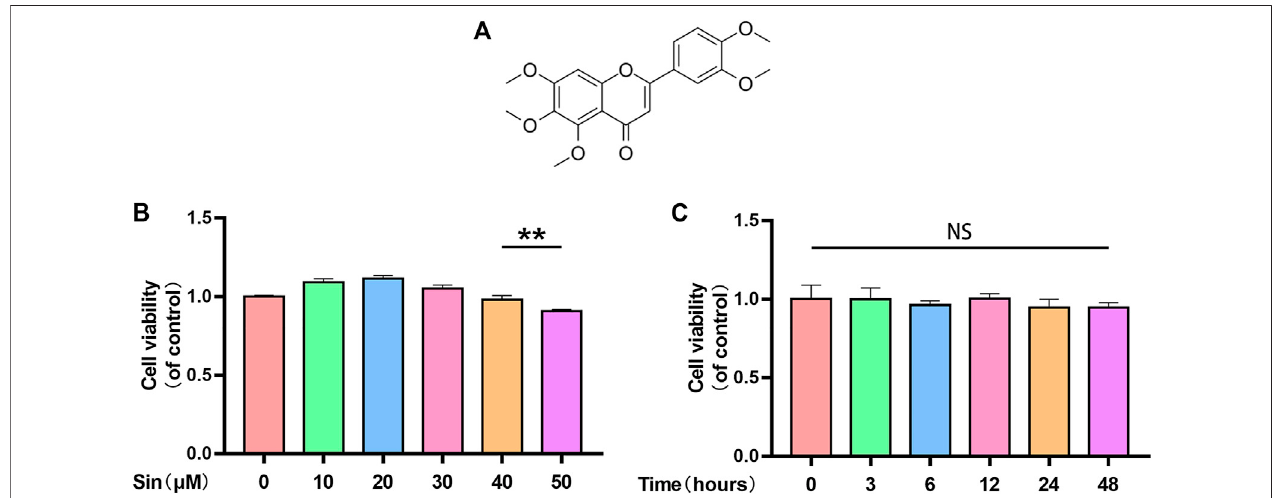
FIGURE 1 | Sin ’ s effect on chondrocyte viability. (A) Chemical structure of Sin. (B) The results of CCK-8 assay show the viability of chondrocytes after treatment with 0, 10, 20, 30, 40, and 50 μ M Sin for 24 h. (C) The results of CCK-8 assay show the viability of chondrocytes after treatment with 40 μ M Sin for 0, 3, 6, 12, 24, and 48 h. The data are presented as the means ± SD ( n (cid:1) 3); * p < 0.05, ** p < 0.01, and *** p <